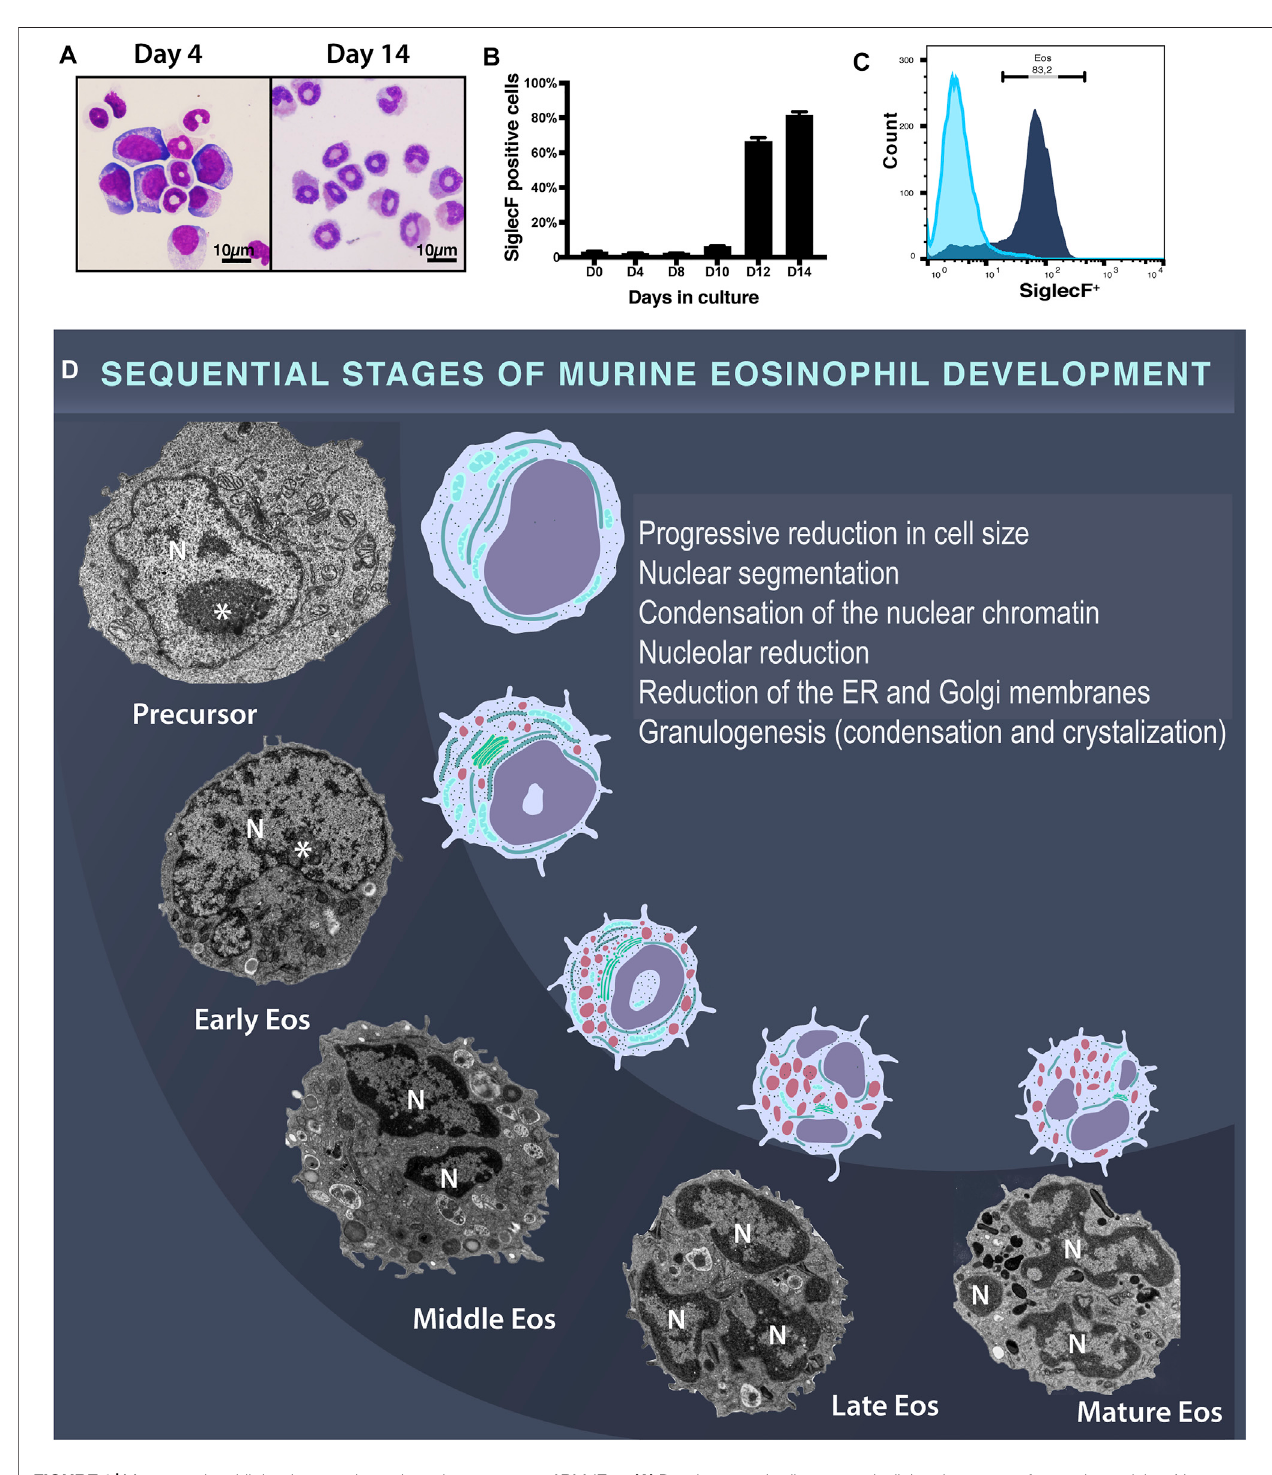
FIGURE1| Mouse eosinophil developmentin exvivo culturesystemsofBMdEos. (A) Developmentalcells seenunderlightmicroscopyafter routine staining.Note thering-shapedeosinophilnuclei. (B,C) FlowcytometricanalysisofSiglecFexpressionin3independentmousecultures. (D) Developmentaleosinophilstagesobserved by TEM. In the early stage of development, eosinophils are characterized by a large, eccentric, and round nucleus with a prominent nucleolus (*), which undergo progressive lobulation. Nuclear changes occur in parallel with a reduction in cell size and in the amount of the endoplasmic reticulum and Golgi membranes. Granulogenesis involves content fi lling, condensation, and crystallization. N, nucleus.